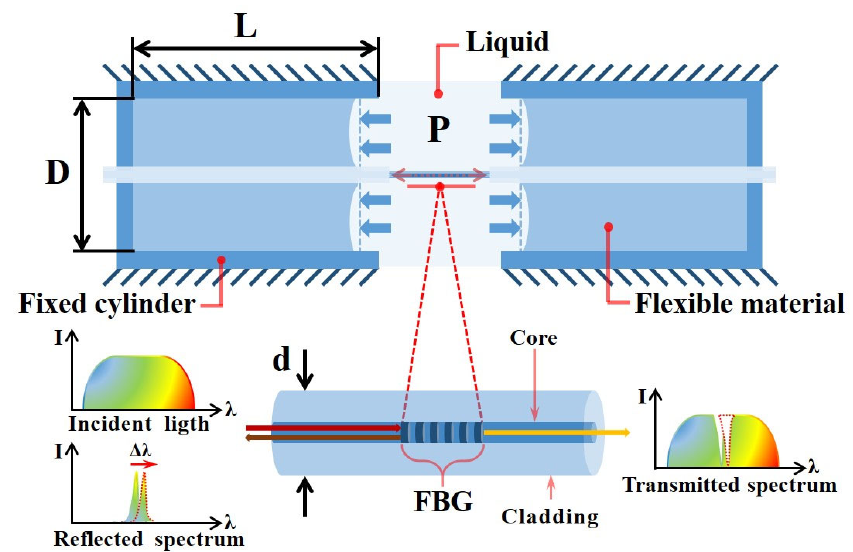
Figure 1. Model of the FBG ‐ based liquid pressure sensor.